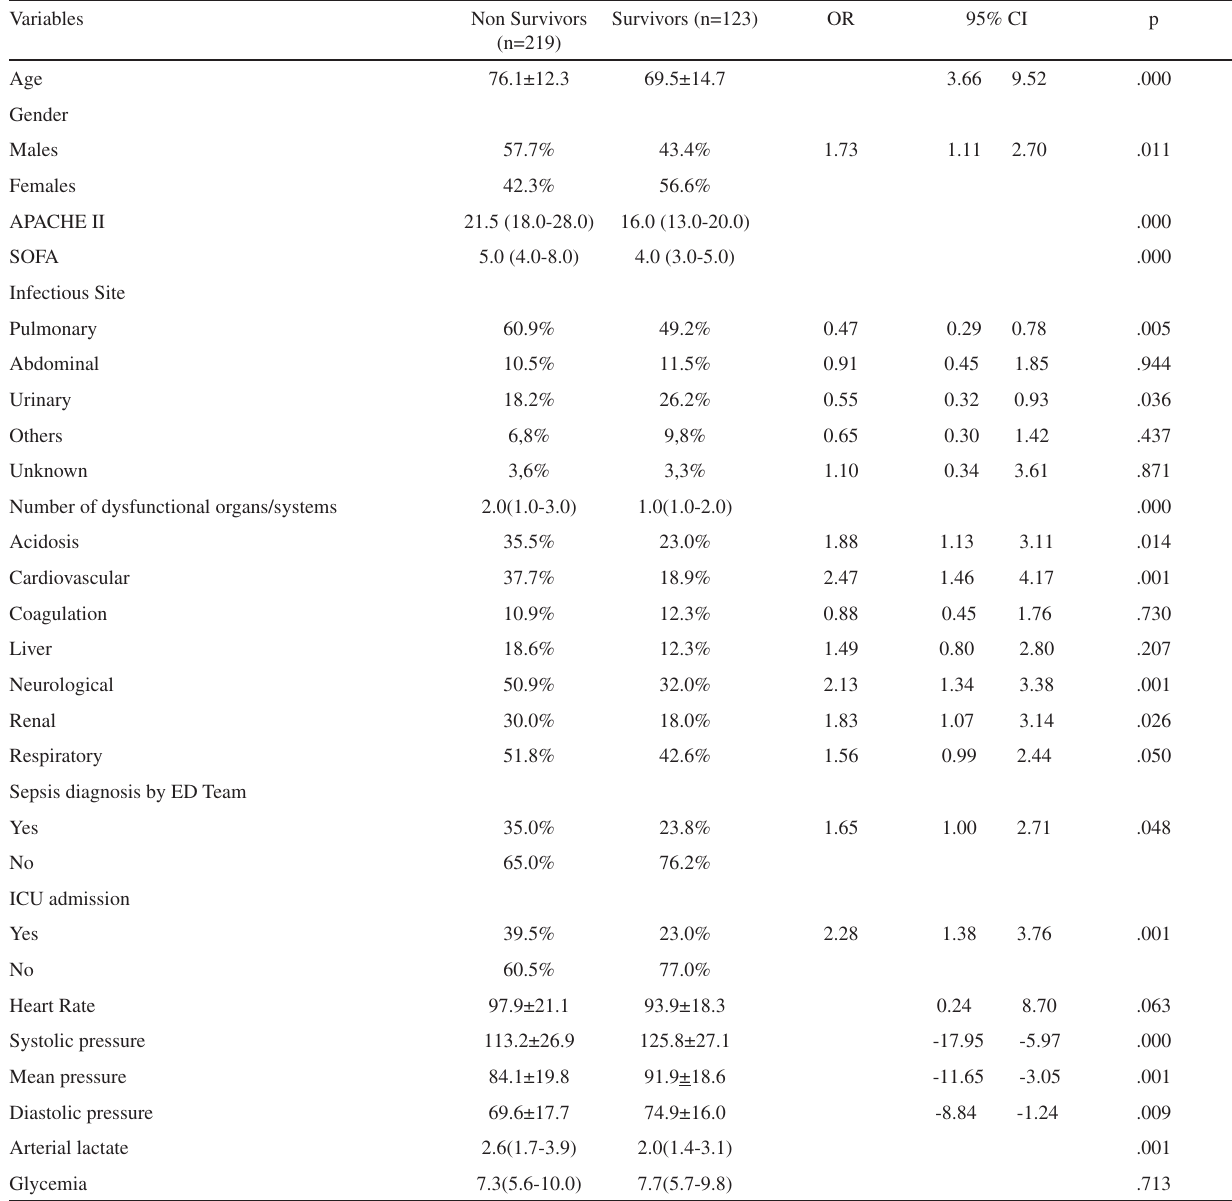
Table 3 - Comparison between survivors and